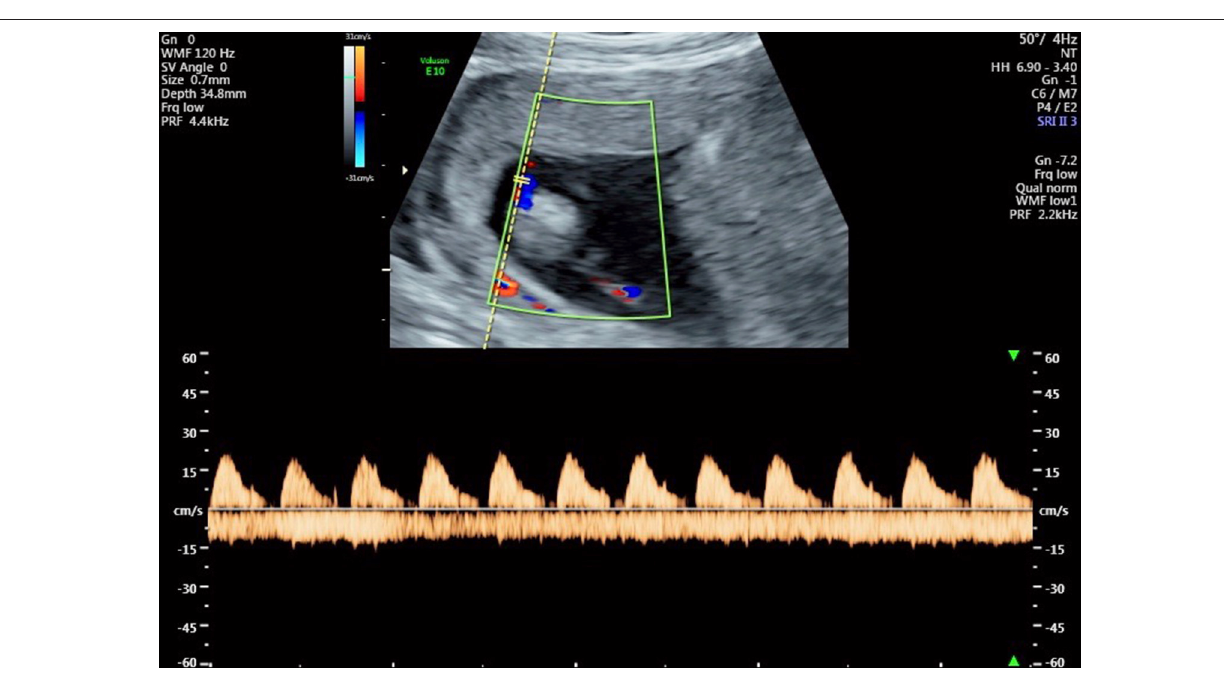
(Gittenberger-de Groot et al., 2013), and with the start of diphasic diastolic filling of the atria, indicative of a more